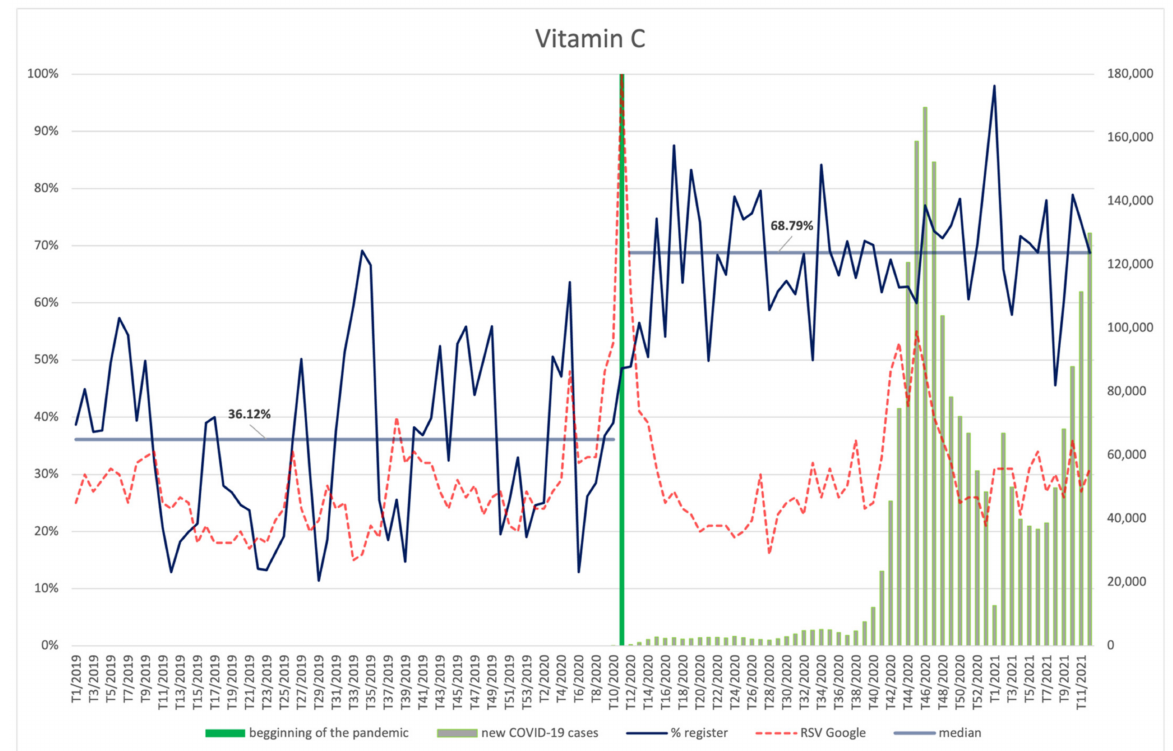
Figure 7. Comparison between the number of new registrations of products containing vitamin C, the number of COVID-19 cases, and the frequency of search for information on the ingredient in the Google browser.